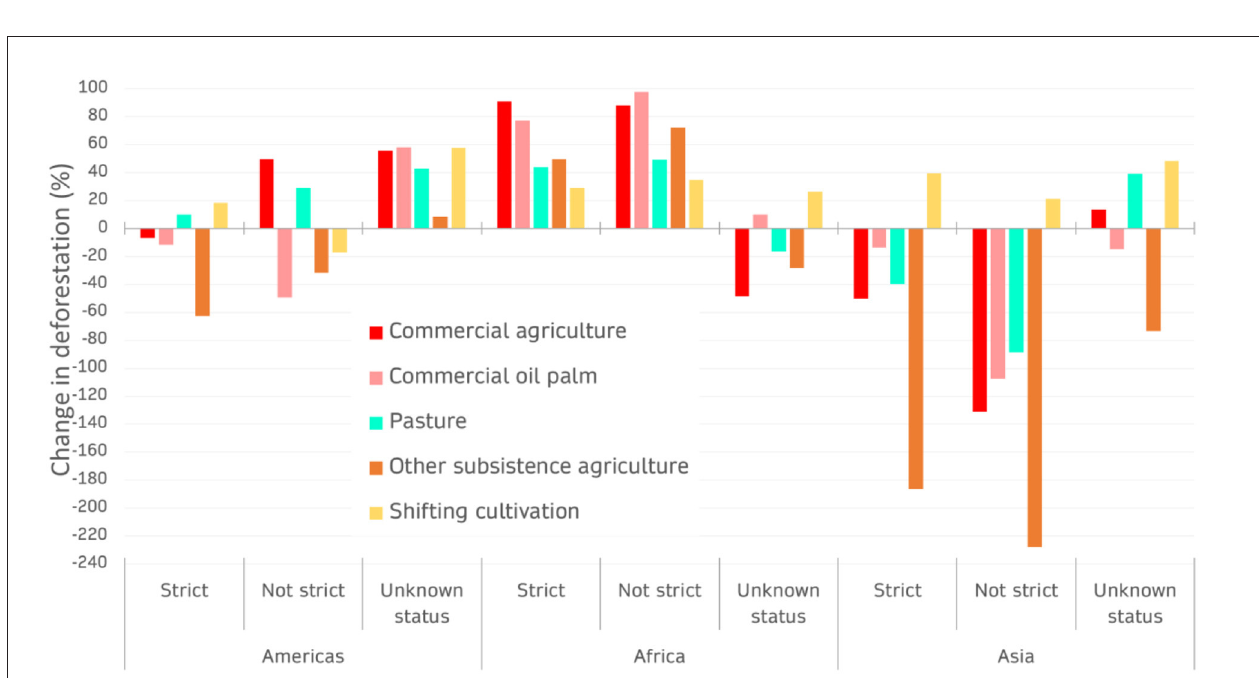
FIGURE 6 | Percentage deforestation in protected areas by driver and degree of protection for the Americas, Africa, and Asia in the area 30 ◦ latitude north and south of the equator.